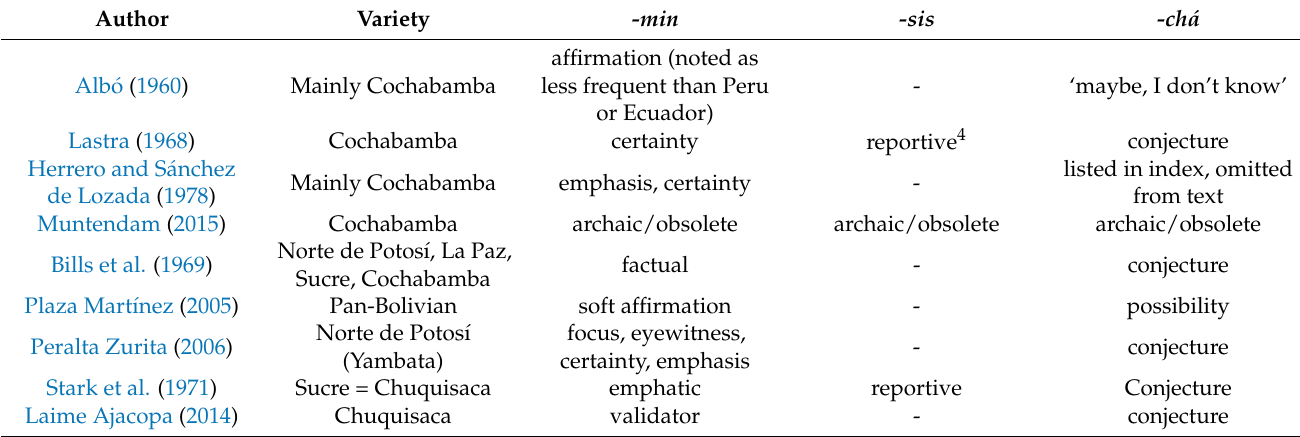
Table 2. Evidential enclitics found in the literature on Bolivian